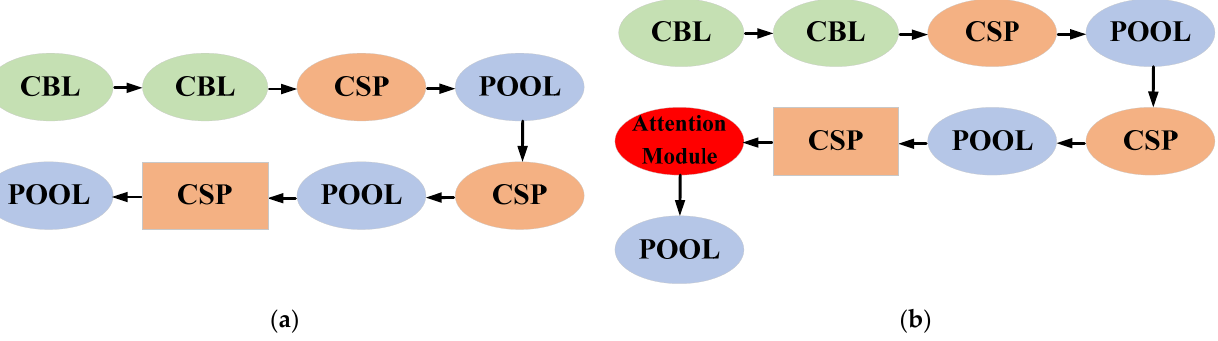
Figure 16. ( a ) The architecture of original YOLOv4-tiny; ( b ) The architecture of improved YOLOv4-tiny with attention module.